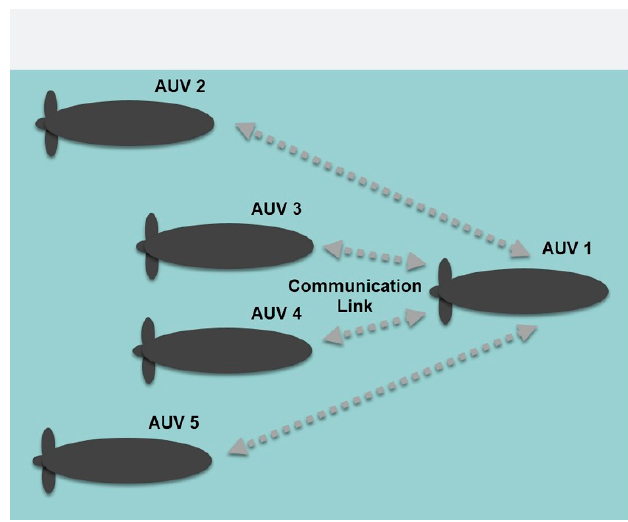
Figure 16. Leader-follower navigation of AUVs with AUV 1 as a leader of the formation.